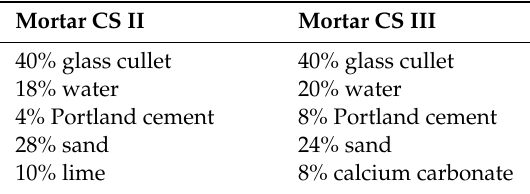
Table 1. Best composition by weight selected for CS II and CS III mortar production.